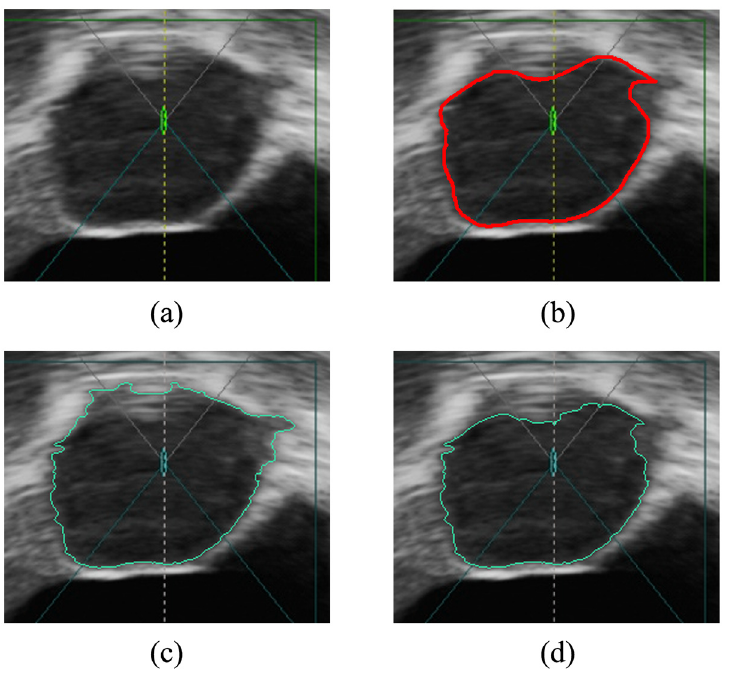
Fig 13. An example of tumor segmentation with different F values. (a) The original image. (b) Standard boundary. (c) Segmentation result when F = 4. (d) Segmentation result when F = 9.